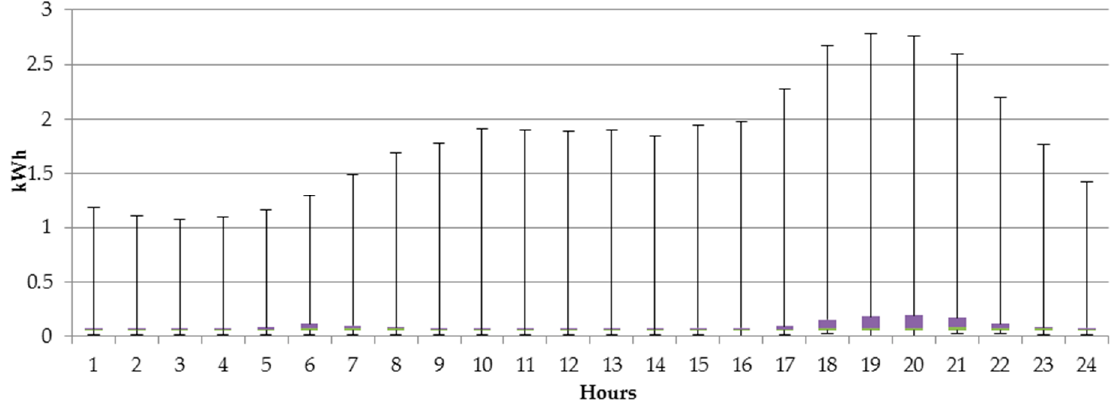
Figure 4. Customer with the most volatile consumption (in kWh) in the analyzed period (January– December 2015).